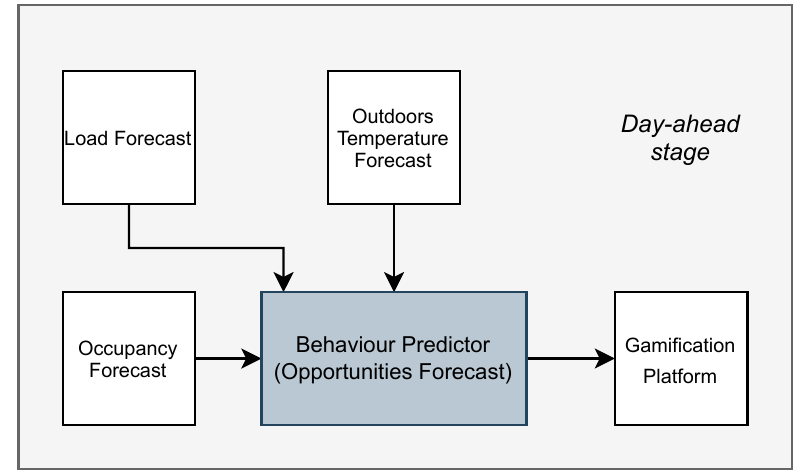
Figure 9. Behaviour Predictor module.